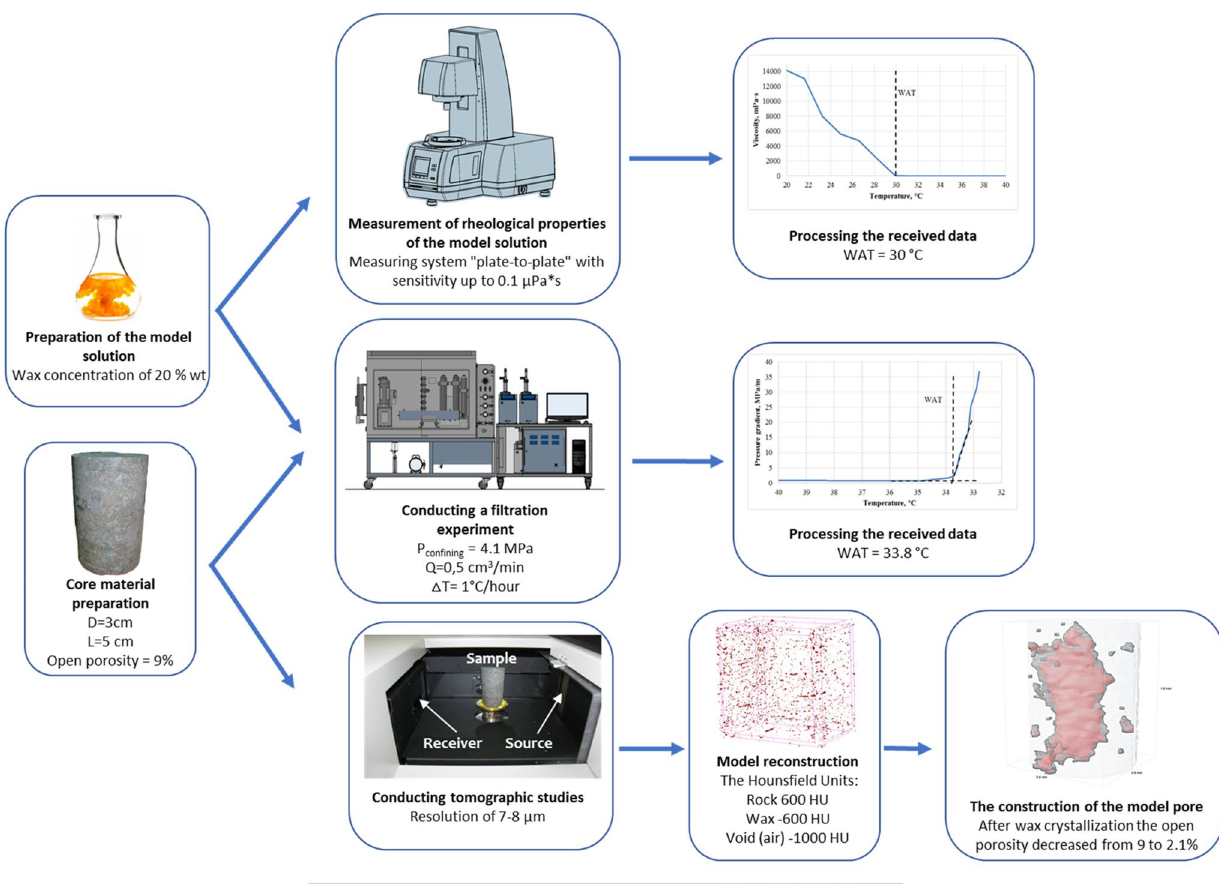
Fig. 2 The experimental procedure flowchart Fig. 3 The dependence of the viscosity of a wax-bearing solu- tion on temperature (viscosity